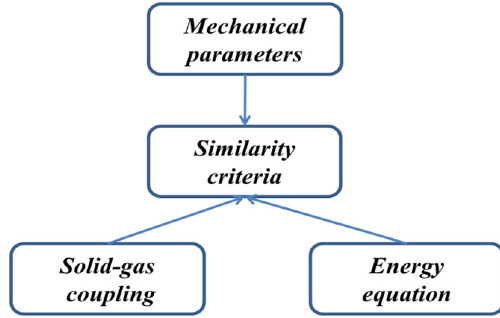
Fig. 1 The derivation process of the similar